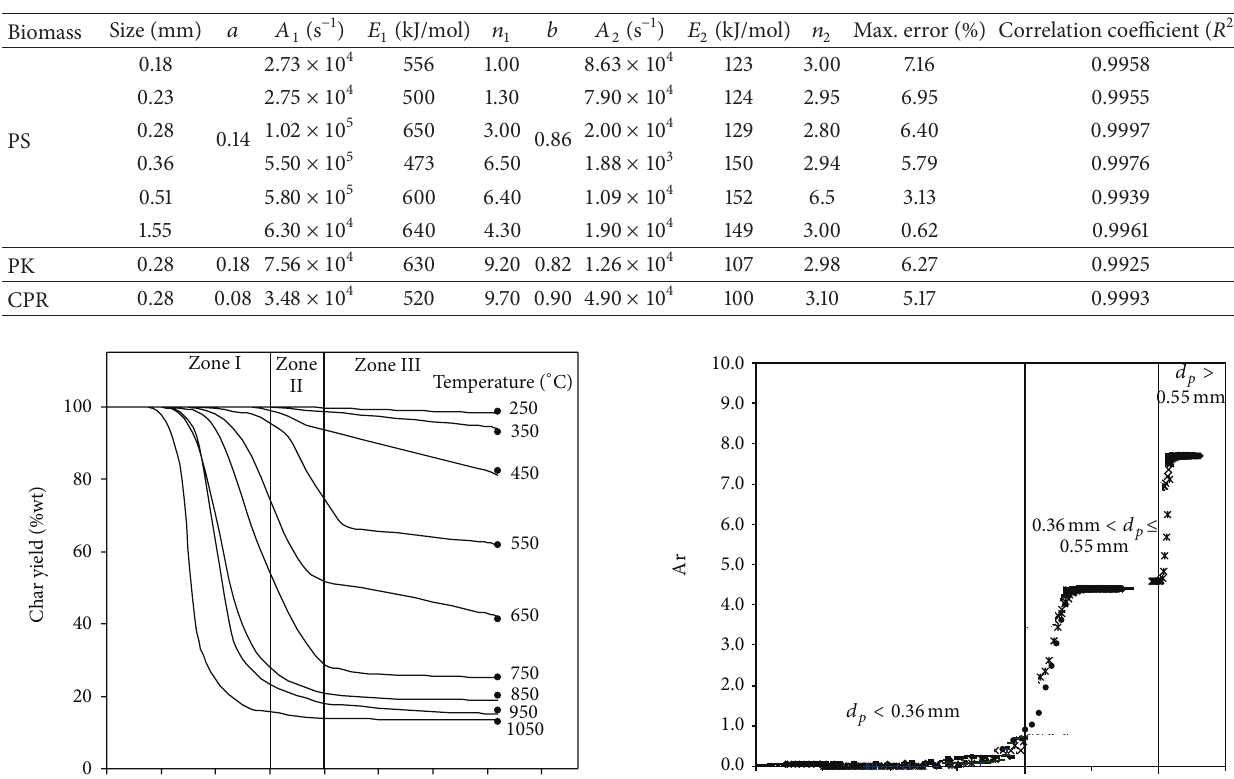
Table 4: Estimated kinetic parameters of biomass pyrolysis in a free-fall reactor.